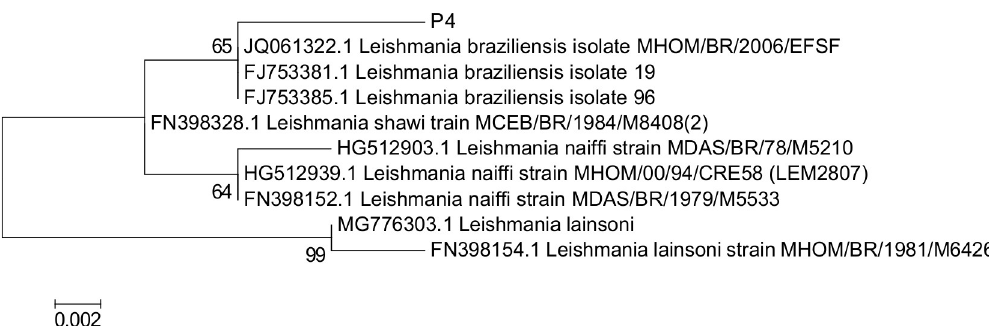
Fig 1. Phylogenetic analysis demonstrating Leishmania (Viannia) species with sequences of ITS1-rDNA. The variant Leishmania braziliensis P4 sequence (GenBank accession number MN508061) is present, with 0.8% of genetic distance when compared to other sequences of Leishmania braziliensis . The evolutionary history was inferred using maximum likelihood based on the Jukes–Cantor model; sequences were aligned using MEGA version 6 software. Outgroup: Leishmania lainsoni . Bootstrap test (1000 replications) are shown next to the branches, and GenBank accession numbers are in front of the species names.